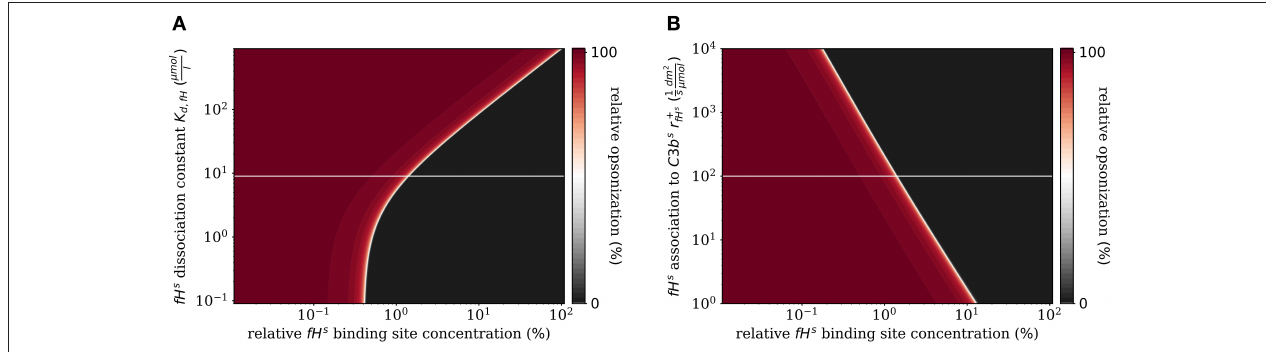
FIGURE 7 | Relative opsonization in the steady state for varied system parameters as a function of the relative Factor H binding site concentration. The white line indicates the DynaCoSys model for standard parameter values. (A) Variation of the dissociation constant for Factor H and binding sites on the cell surface. (B) Variation of the reaction rate for fH s binding to C3b s